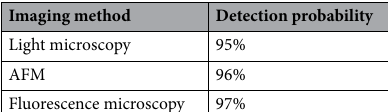
Table 1. Probability of cell detection for light microscopy, AFM, and fluorescence